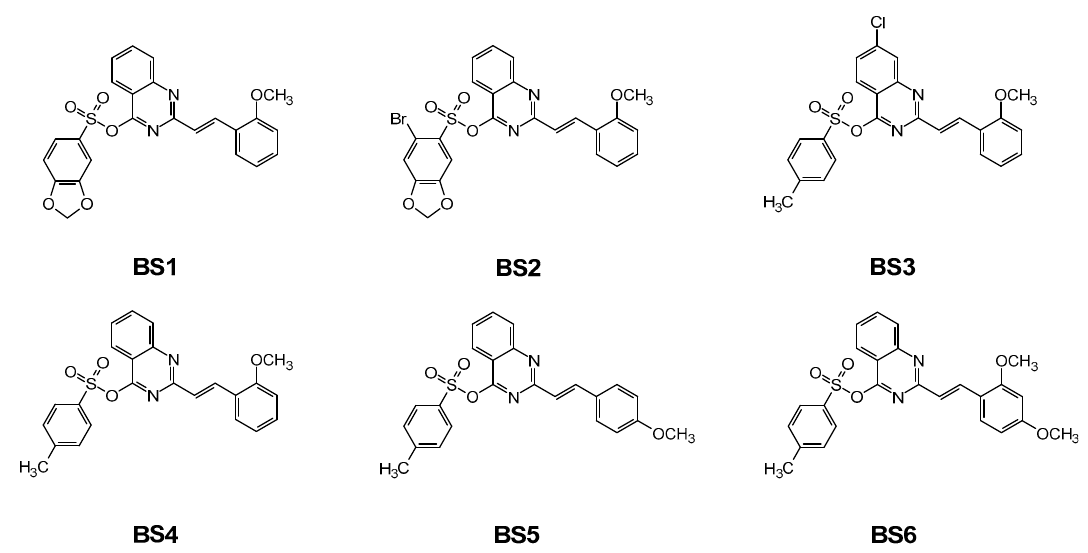
Figure 2. Structures of the studied compounds.